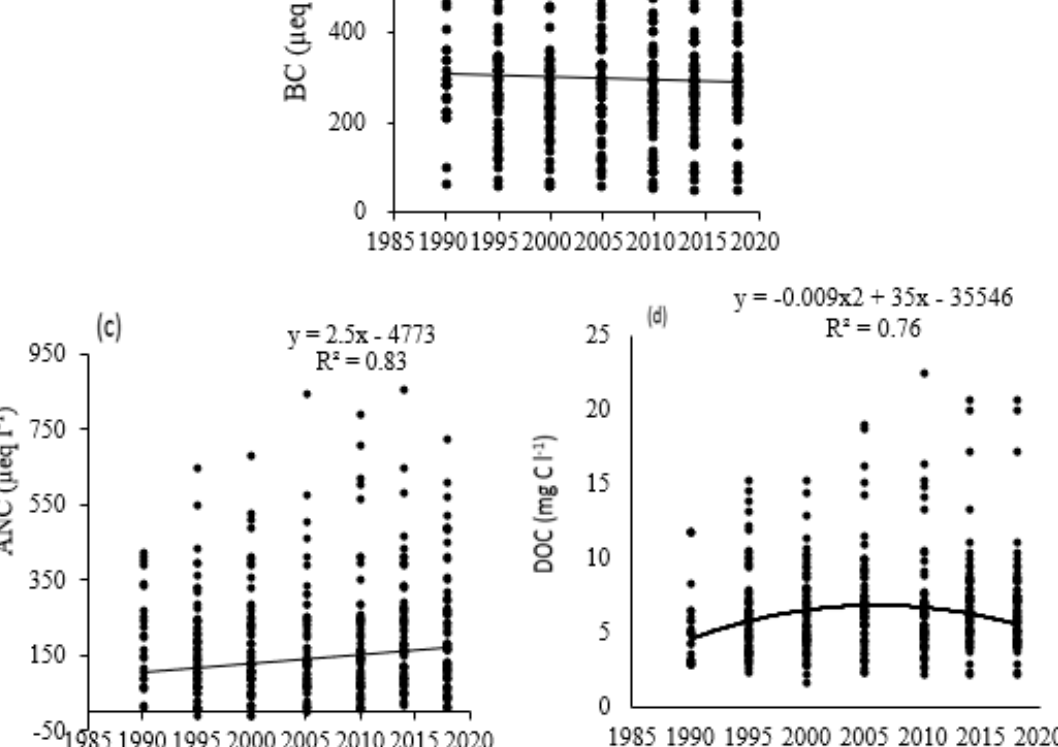
Figure 3. Trends change of water chemistry parameters of the water bodies for a 28-year period (1990–2018): ( a ) SO 4 * ( µ eq L − 1 ), ( b ) BC ( µ eq L − 1 ), ( c ) ANC ( µ eq L − 1 ), ( d ) DOC (mgC L − 1 ); dots are values, lines are trends.